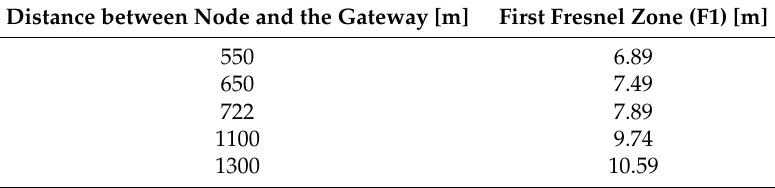
Table 5. First Fresnel zone